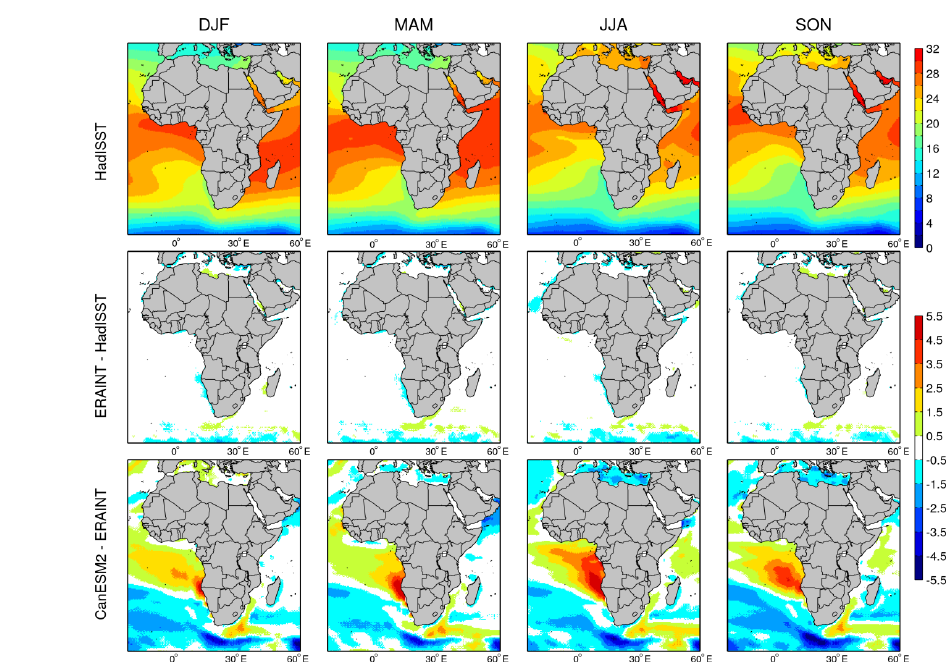
Figure A1. Seasonal sea-surface temperature ( ◦ C) from the observational SST dataset HadISSTv1.1 (first row; Rayner et al., 2003), and the biases of ERA-Interim (second row) and CanESM2 (third row) against the observed biases for the period 1997–2010.